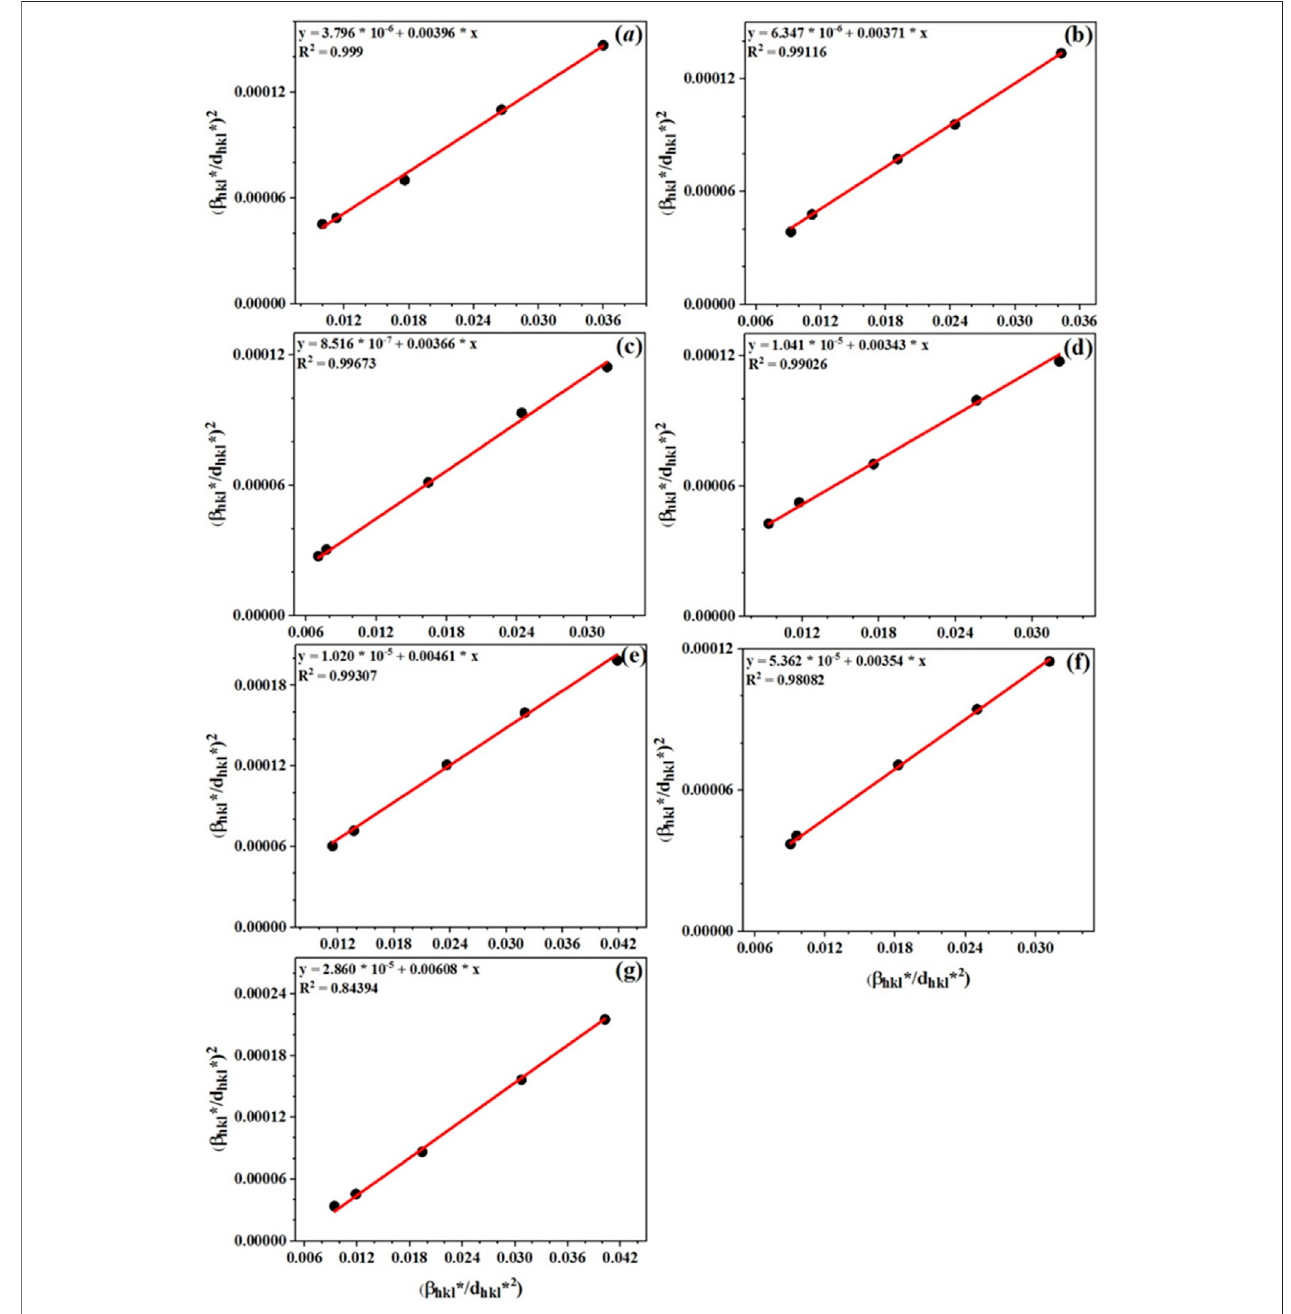
) 2 versus ( β p 2 hkl ) for samples with (A) x (cid:1) 0.00, (B) x (cid:1) 0.05, (C) x (cid:1) 0.10, (D) x (cid:1) 0.15, (E) x (cid:1) 0.20, (F) x (cid:1) 0.25, and (G) d p hkl d p 2 hkl